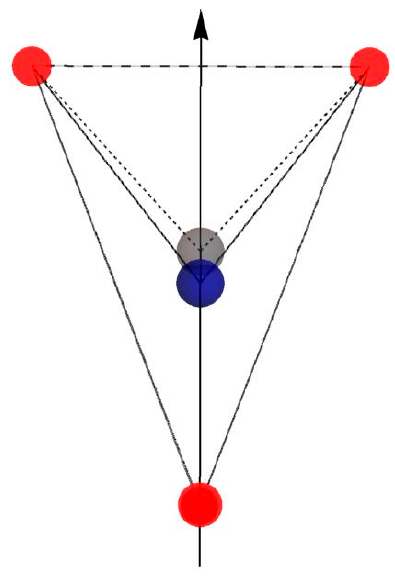
Figure 4. [BaO 4 ] and [CeO 4 ] tetrahedra with marked angles O-Ba-O, O-Ce-O and c -axes.